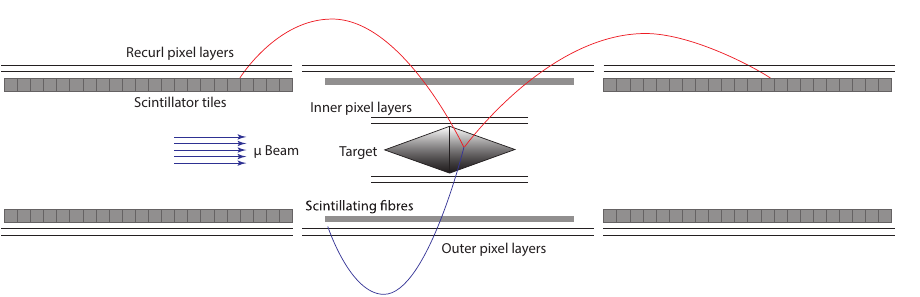
Figure 4: Schematic of the phase I Mu3e experiment in lateral projection with a simulated µ → eee event.